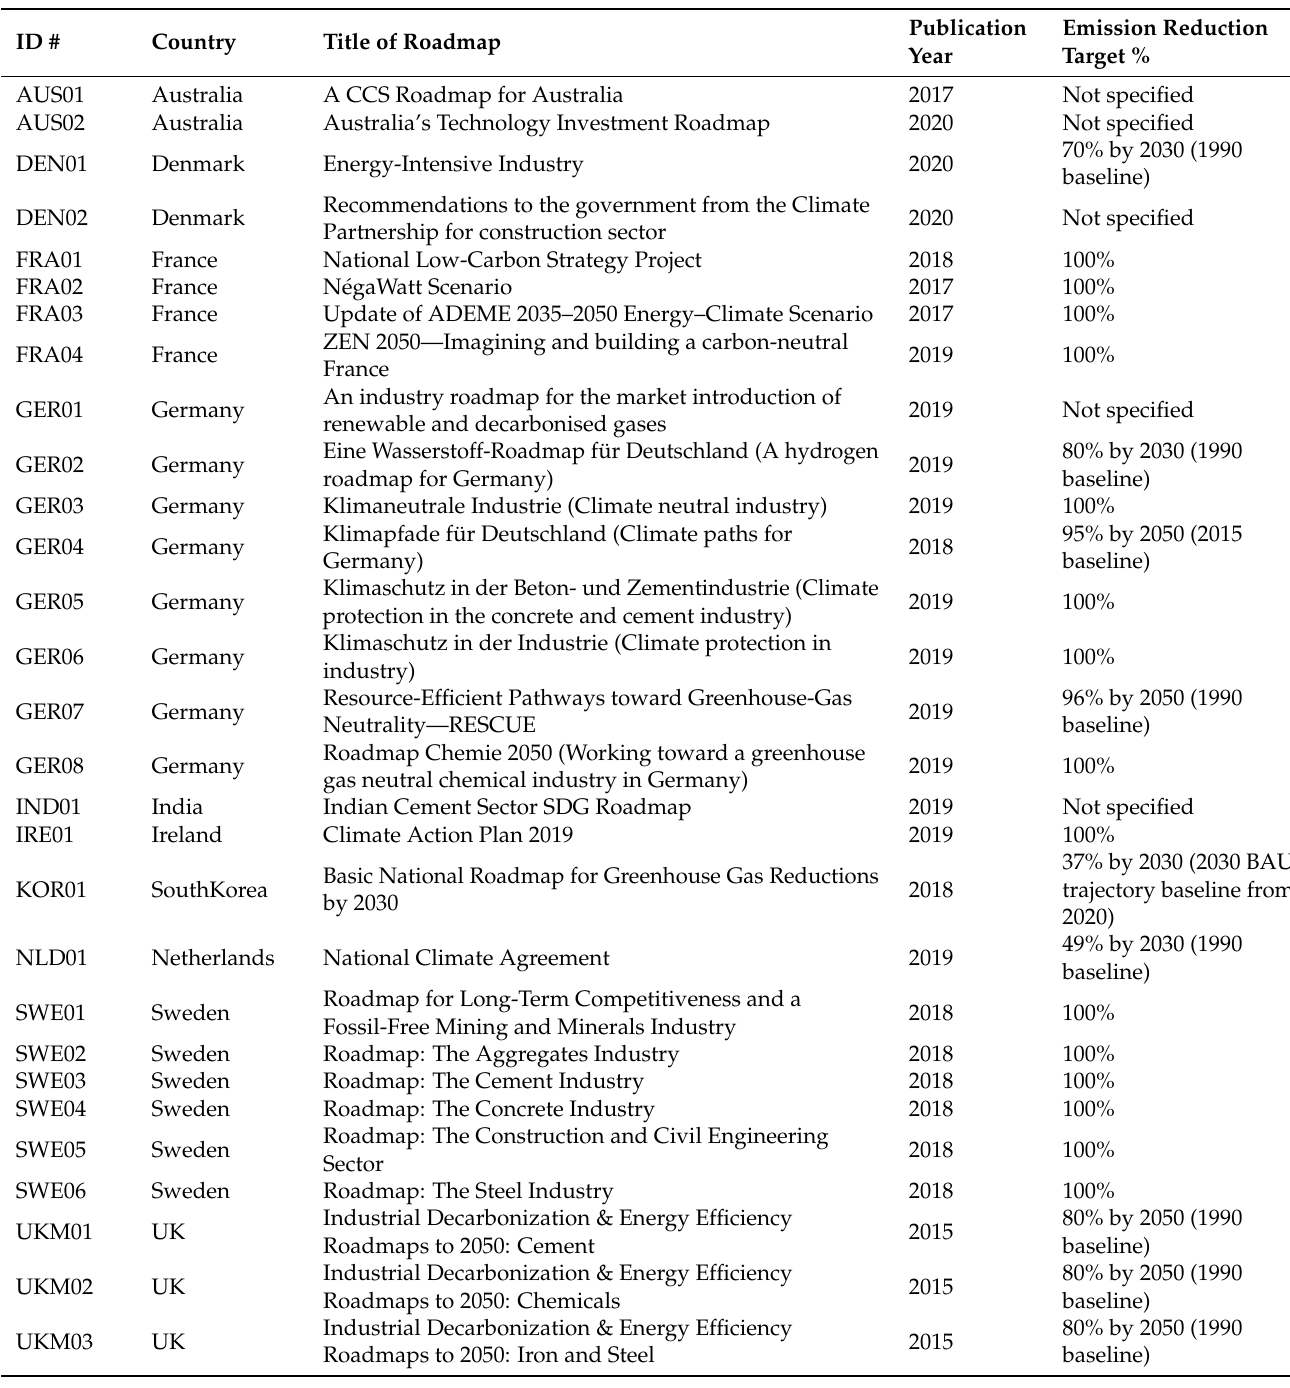
Table 2. List of roadmaps included in analysis, including emission reduction targets (source: author’s